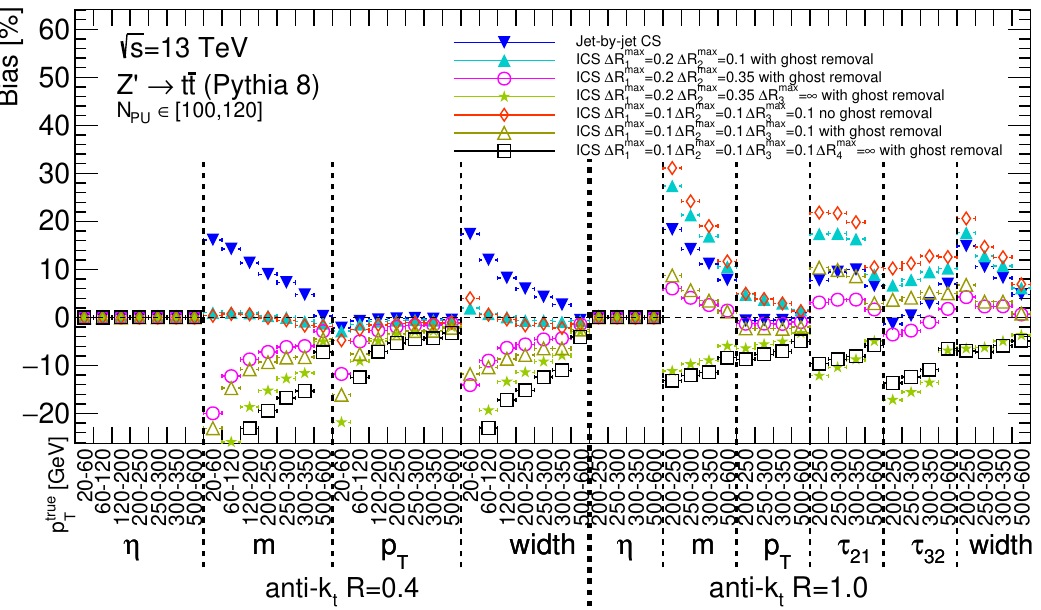
Figure 18. Bias for a representative set of con(cid:12)gurations for the ICS method with three or more iterations. The (cid:1) R max parameter for the individual iterations is varied and the ghost removal option is used or not. The other CS parameters are set to (cid:11) = 1 and A g = 0 : 0025 for each